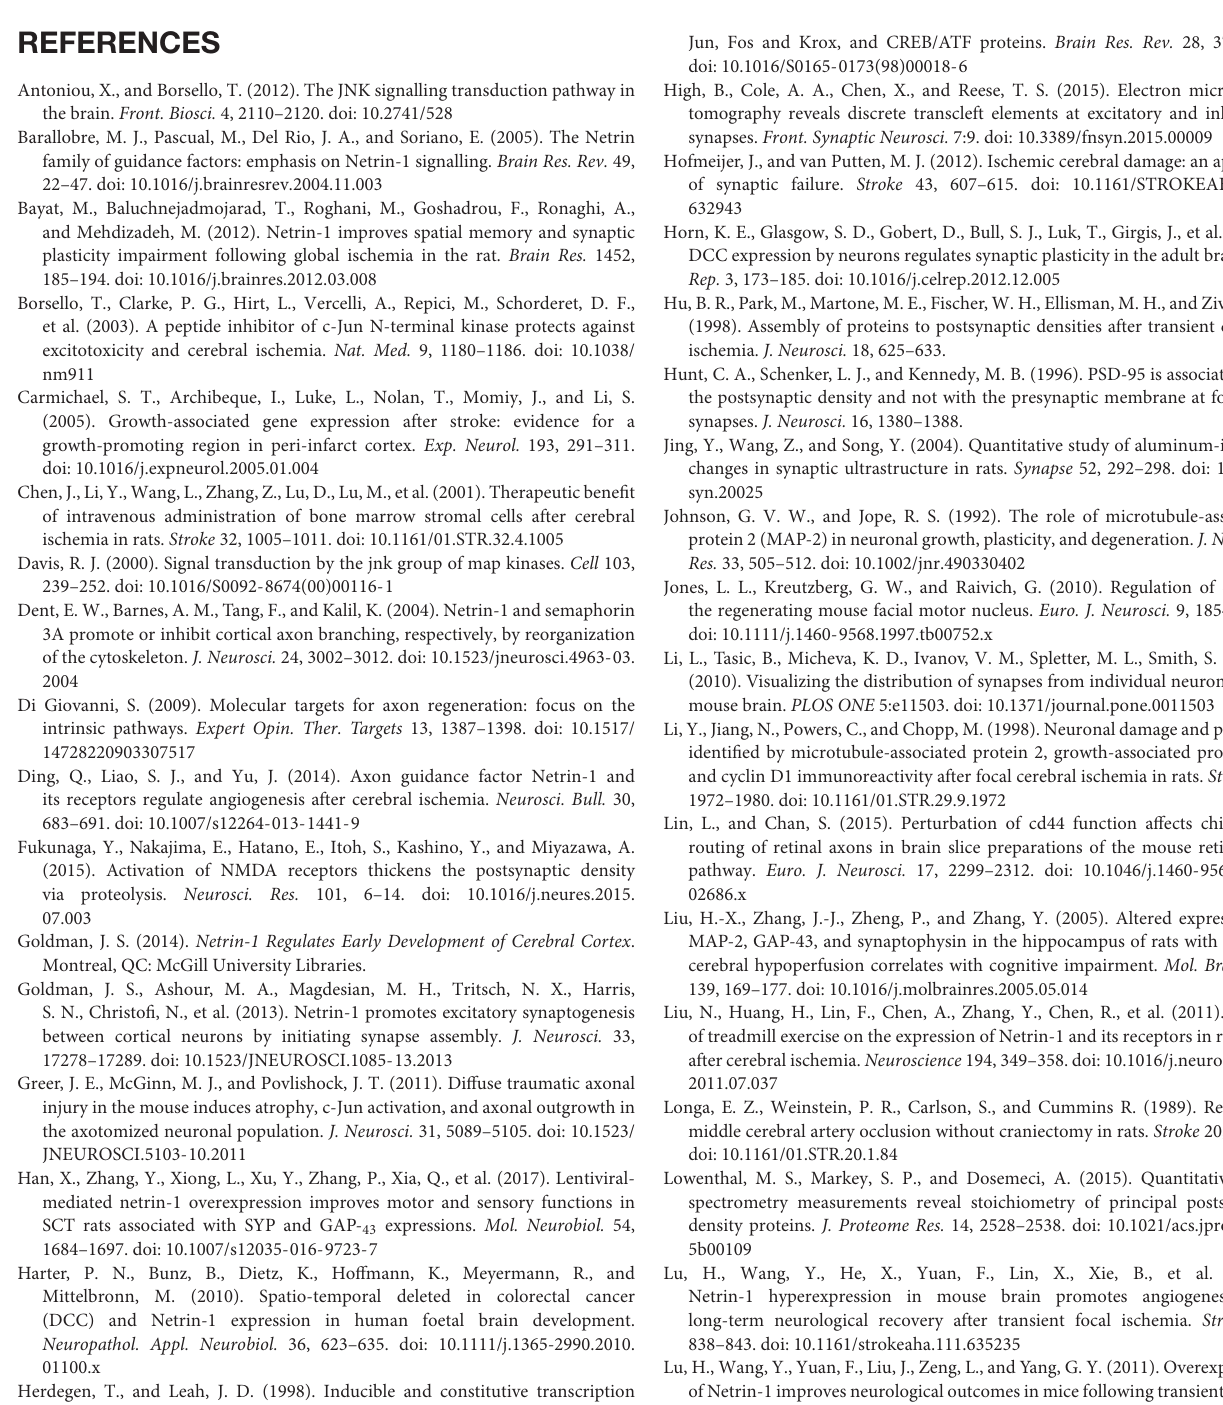
FIGURE S2 | Western-blot analysis of the supplementary groups. (A) The representative images of western-blot analysis for PSD-95 and SYN. Rats in each group were sacrificed at Day 14 after the MCAO. (B) Western-blot analysis of PSD-95 ( n = 3), ∗ p < 0.05, as compared with the AAV-empty group; ∗ p < 0.05, as compared with the AAV-empty + DMSO group. (C) Western-blot analysis of SYN ( n = 3), ∗ p < 0.05, as compared with the AAV-empty group; ∗ p < 0.05, as compared with the AAV-empty + DMSO group.